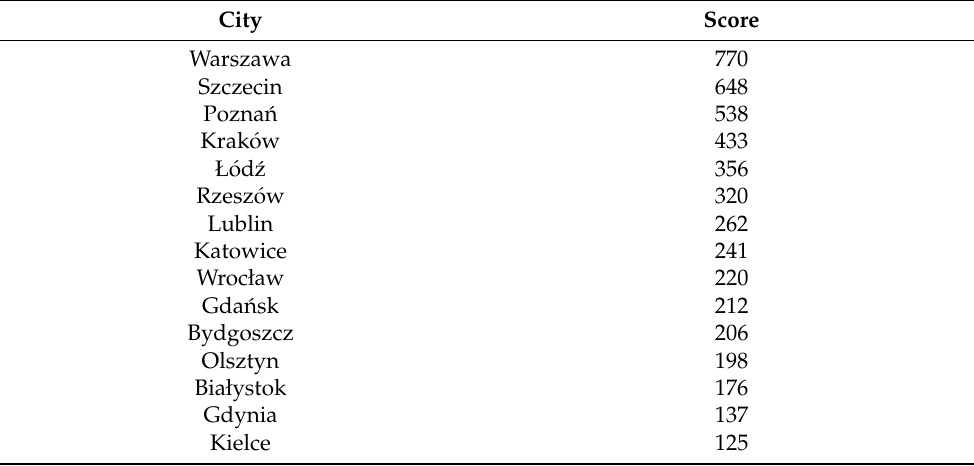
Figure A4. Map with access to banking services points for the whole of Poland Source: Prepared by the authors using Tableau Desktop Professional Edition. Table A2. Higher scores (per city) derived from applying the